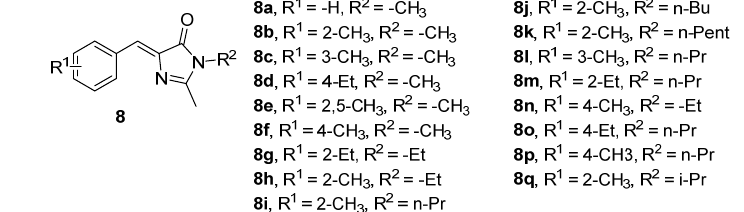
Figure 8. GFPc analogues demonstrating an increased emission intensity in the presence of a deep cavity cavitand [22].